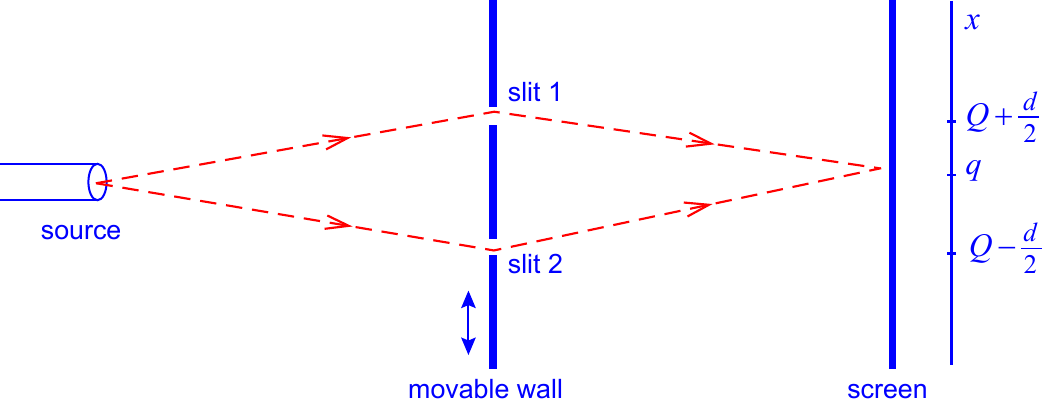
Figure 1: An illustration of the Einstein–Bohr recoiling slit experiment. Einstein proposed, in his debate with Bohr, that a particle passing through a movable wall with two slits will form interference pattern on a screen behind the two slits, but at the same time the momentum imparted on the movable wall will tell us which slit the particle has passed